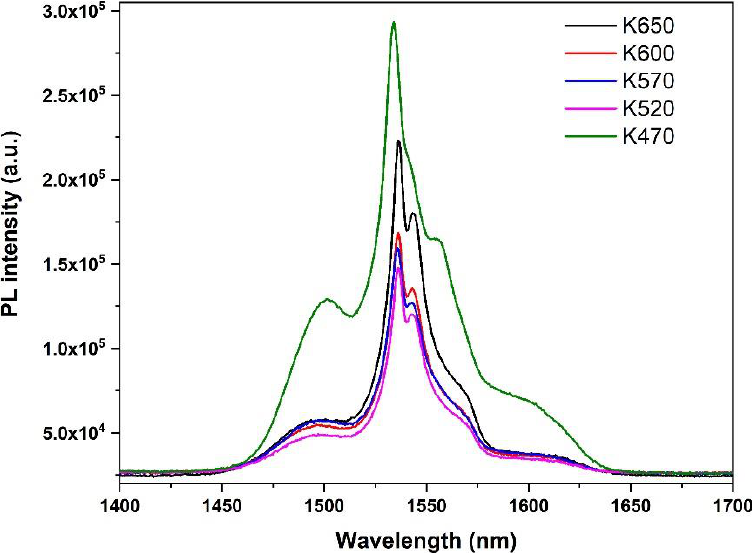
Figure 16. XPS survey spectrum for the sample prepared using a substrate temperature of 570 ◦ C (K570).